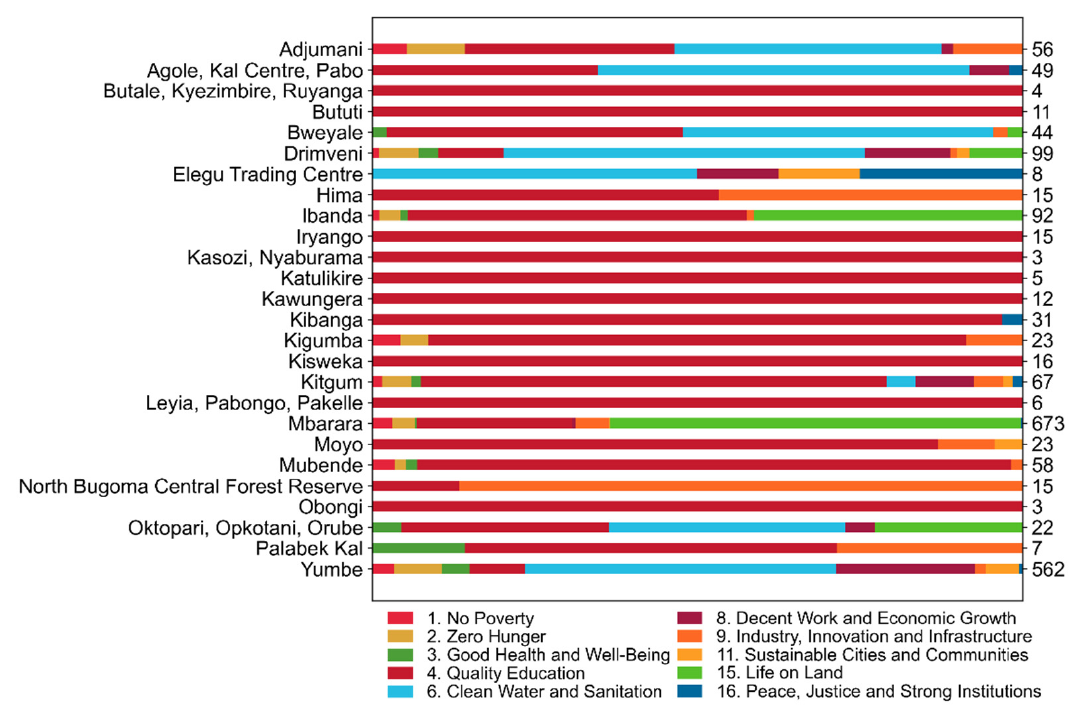
Figure 13. Relative distributions of SDG-relevant OSM data at non-refugee settlements. The total number of SDG-relevant OSM features within each settlement are listed on the right-hand side.